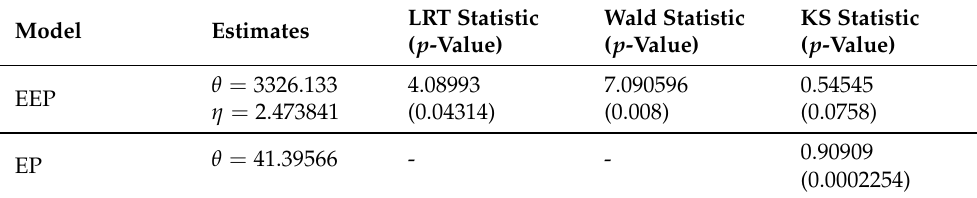
Figure 10. TTT plot ( left ) and box plot ( right ) of the time to electric breakdown data set. Table 6. Summary of the EEP and EP fit to the time to electric breakdown set.